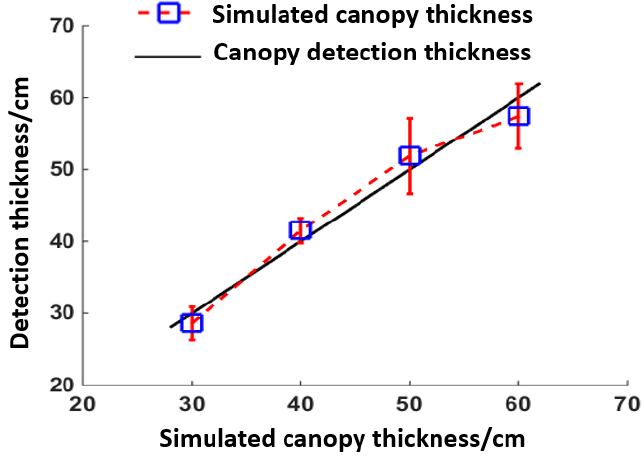
Figure 7. Canopy detection thickness curves under different simulated canopy